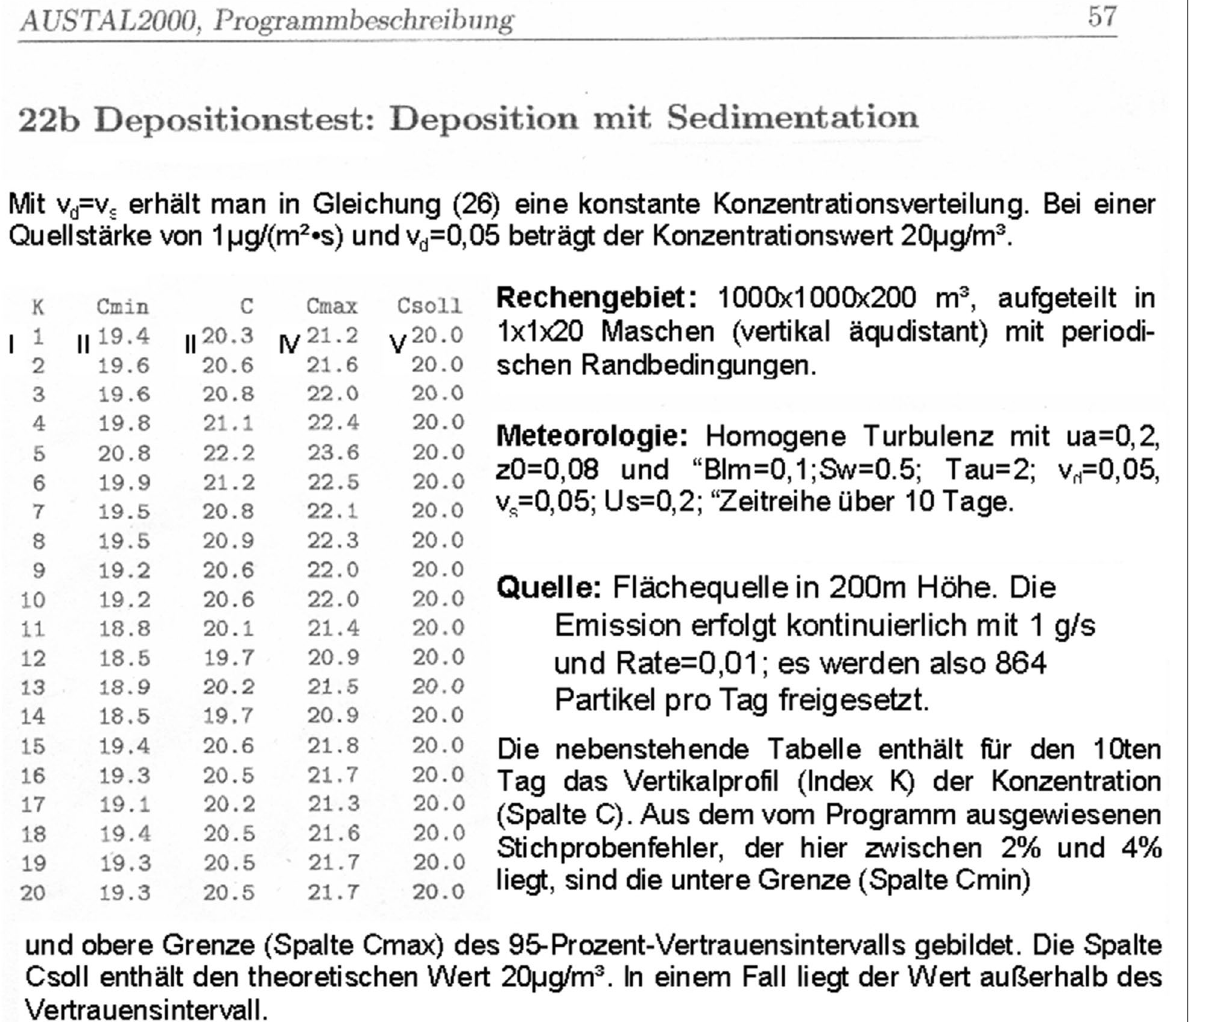
Fig. 5 Task of the AUSTAL authors “Deposition with